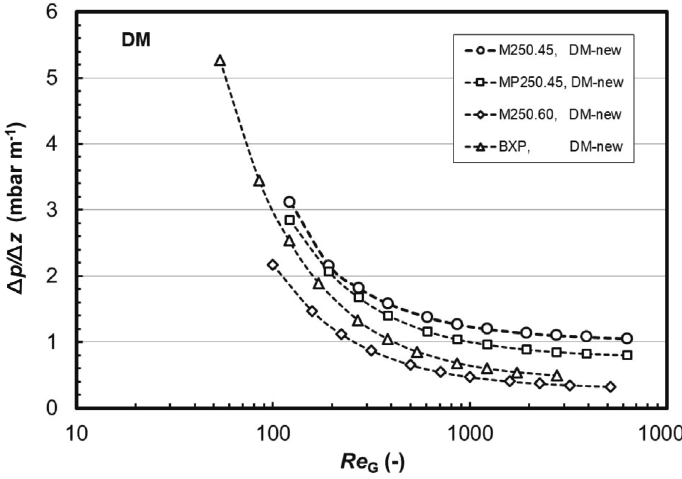
Fig. 7 – Specific pressure drop as estimated by extended DM (DM-new) for four structured packings considered in present study in conjunction with given hypothetical base case